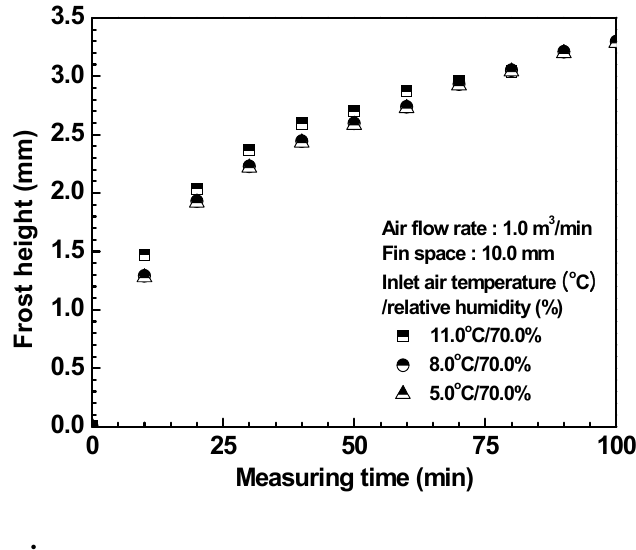
Figure 7. Frost height with the variations of the inlet air